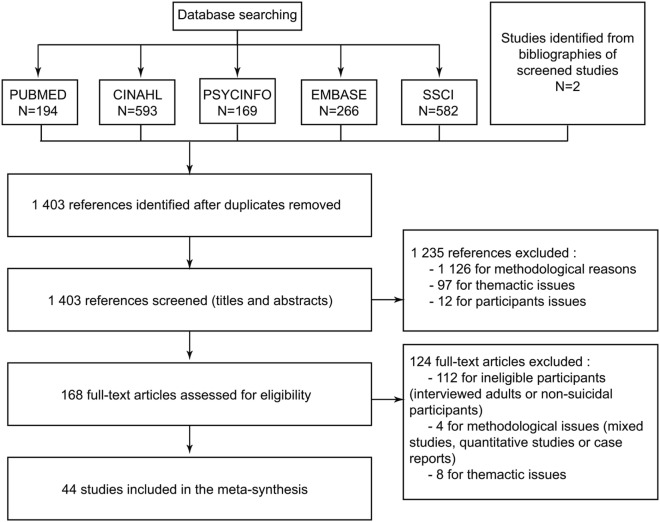
Flowchart for selecting studies from Ref. (22).